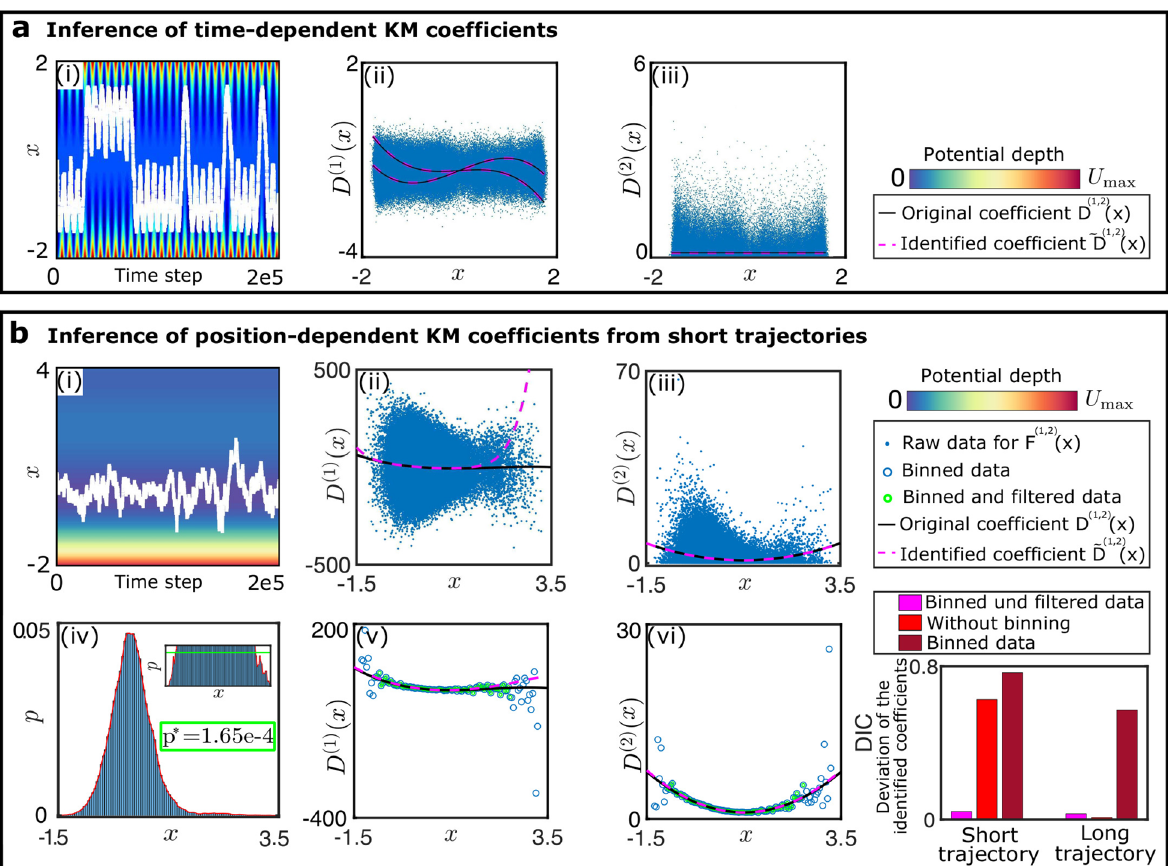
Figure 2. Inference of KM coefficients for one-dimensional SDEs. ( a ) System with a time-dependent force field. ( a-i ) Trajectory of an overdamped motion in a time-varying double-well potential. ( a-ii , iii ) Using an appropriate function library, the functional forms of the KM coefficients can be faithfully reconstructed. Blue dots are values of F ( 1,2 ) estimated from the trajectory. ( b ) Advantage of data binning for analysis of short trajectories. ( b-i ) Trajectory resulting from overdamped motion in a double-well potential with space-dependent diffusion coefficient. ( b-ii , iii ) Inferred x-dependence of the KM coefficients for short trajectories ( 2